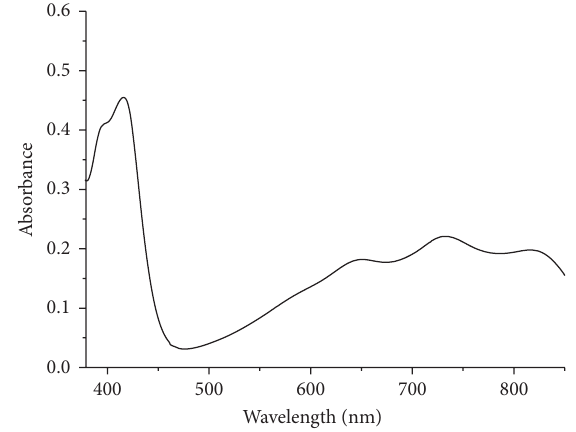
Figure 4: UV-Vis absorption spectrum of ABTS + H 2 O 2 + 7 , recorded 10min after mixing the